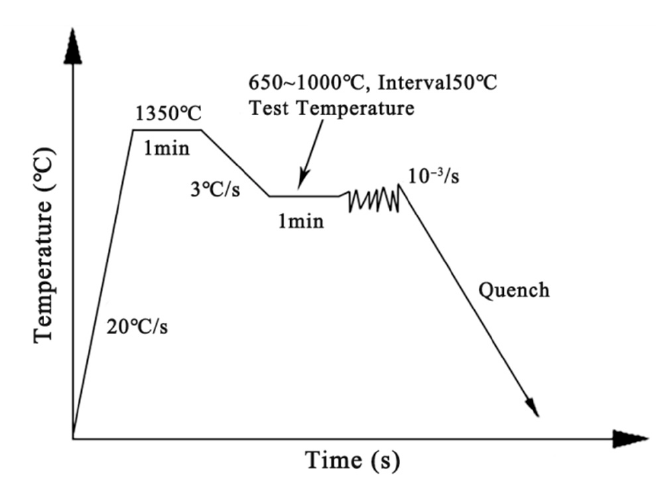
Figure 2. Schematic diagram of the tensile test process.